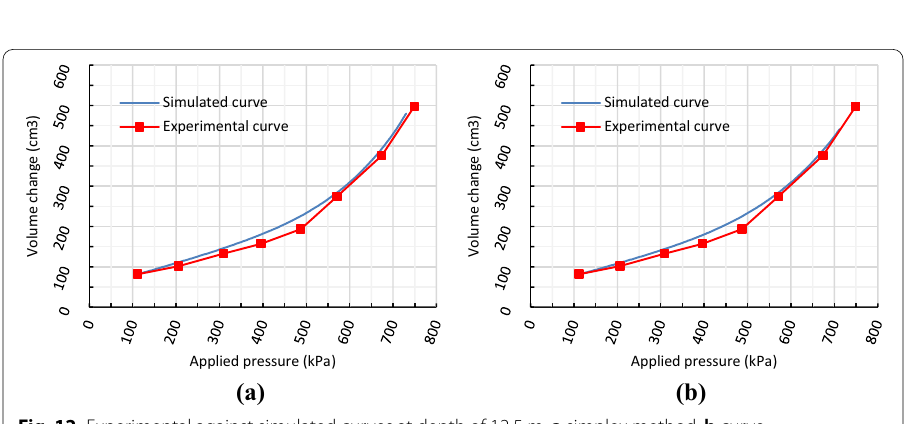
Fig. 12 Experimental against simulated curves at depth of 12.5 m, a simplex method, b curve decomposition